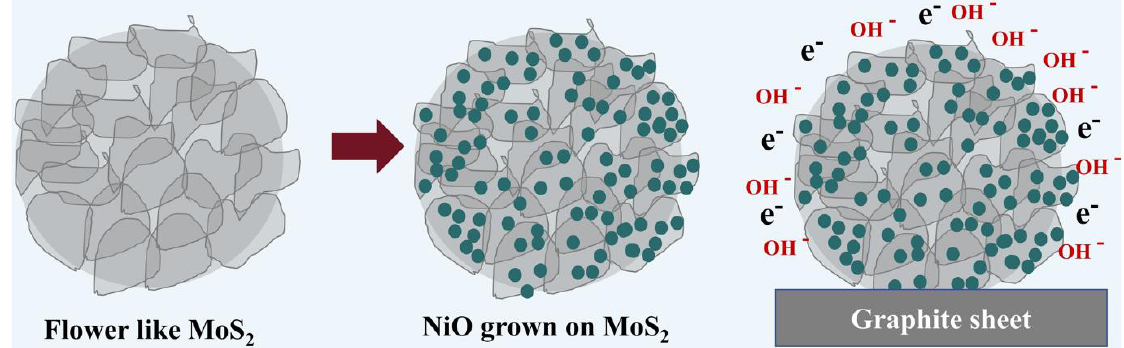
Figure 6. ( a – d ) GCD curves of N, M, NM3, and NM10, respectively, with various current densities; ( e ) comparison of GCD for N, M, NM3, and NM10 with 0.5 current density; ( f ) GCD stability of N, M, NM3, and NM10 at 1 A/g current density for 2000 cycles.